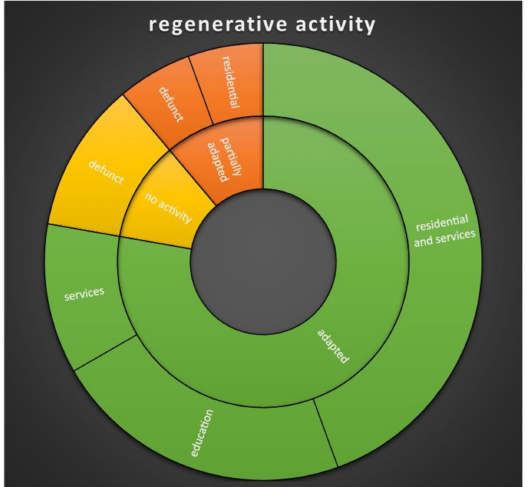
Figure 3. The share of adapted complexes in the general pool of barracks in Legnica and functions of the regenerated objects (by M.